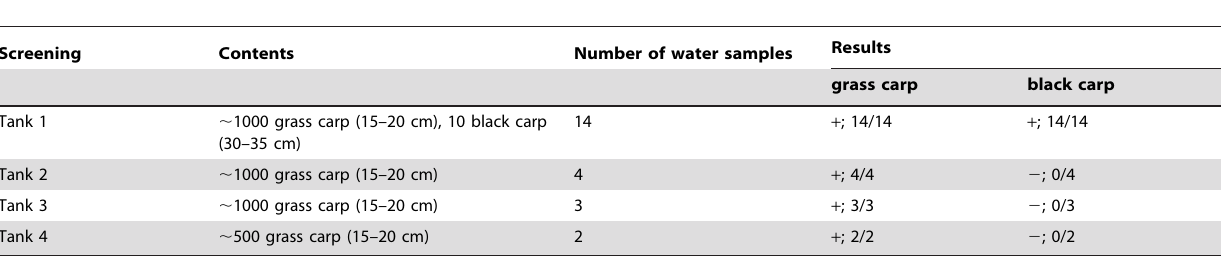
Table 1. Screening of the species-specific primers for amplification of captive black carp and grass carp environmental DNA in large, flow-through tanks.